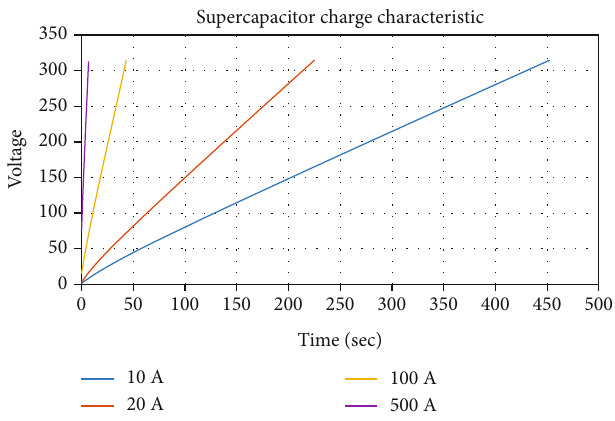
Figure 6: The supercapacitor charge